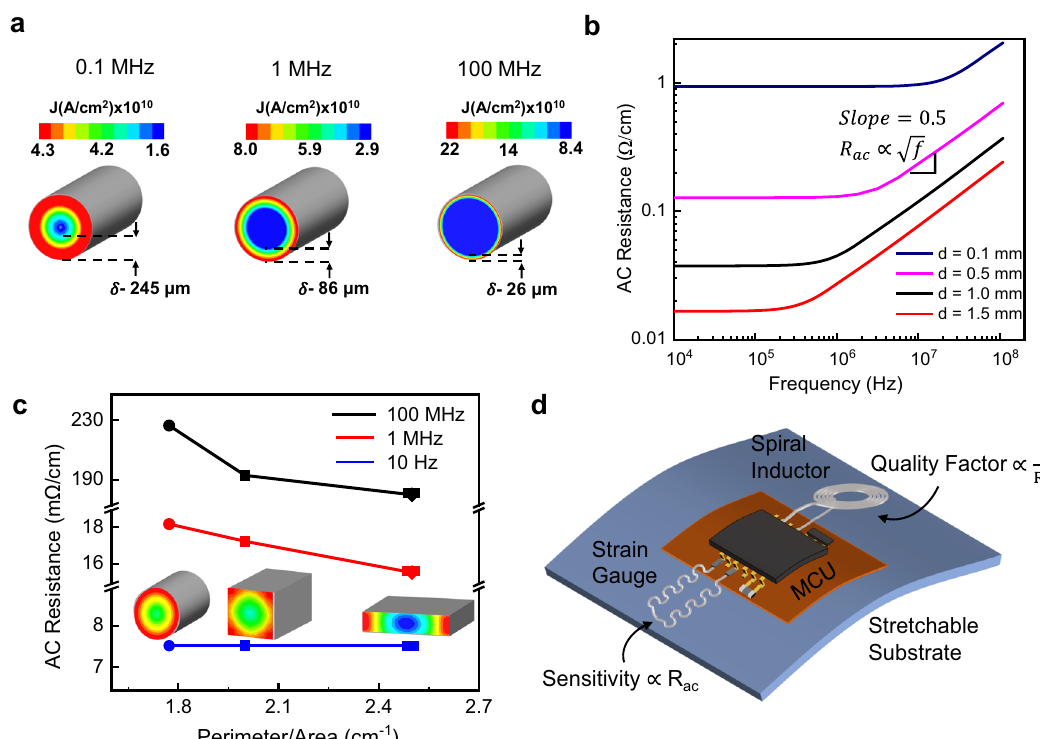
Fig. 1 Finite element analysis simulated AC resistance for liquid metal- fi lled conductors for fl exible electronics applications. a Current density maps illustrating simulated bulk vs. surface current crowding for low (100 kHz, left), medium (10 MHz, middle) and high (100 MHz, right) frequency signals. b Simulated AC resistance per length of liquid metal conductors of varying diameter as a function of frequency, indicating the positive power law scaling with frequency. c Simulated AC resistance of circular, square, and rectangular cross-section conductors as a function of their perimeter to area ratio at low (10 Hz), medium (1 MHz), and high (100 MHz) frequency signals. Inset shows current density maps for circular, square, and rectangular conductor cross-sectional geometries. d A fl exible integrated circuit consisting of passive AC devices with high quality factor and sensitivity made from liquid metal